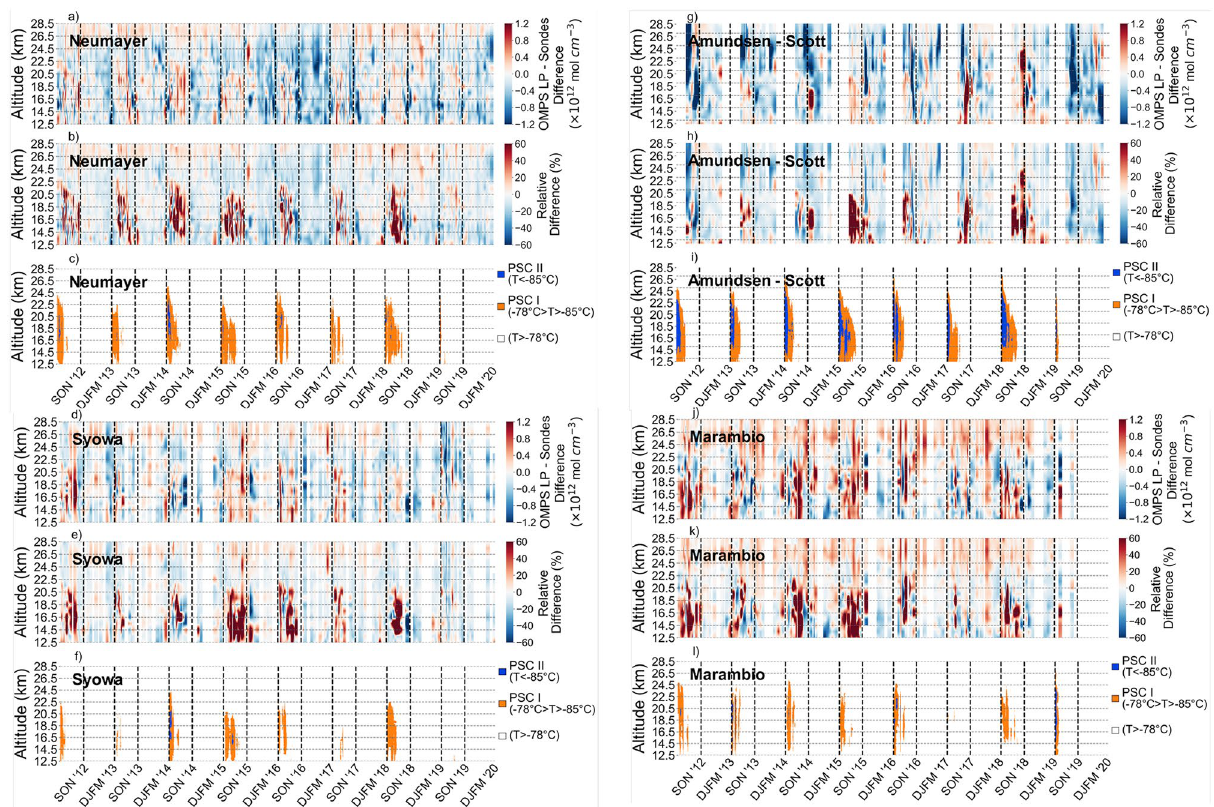
Figure 3. Heatmap of the differences (absolute and relative) between OMPS-LP-derived estimates and balloon- borne measurements; blank spaces indicates periods within which no sondes fulfilling the comparison criteria were available. Periods and altitudes at which the temperature favors the formation of polar stratospheric clouds (PSC) are shown below the heatmaps; temperature profiles from sondes were used. Dashed vertical lines separate different periods per year (DJFM and SON). ( a – c ) Neumayer; ( d – f ) Syowa; ( g – i ) Amundsen-Scott; and ( j – l ) Marambio. Plots were generated by using Python’s Matplotlib Library 63 .